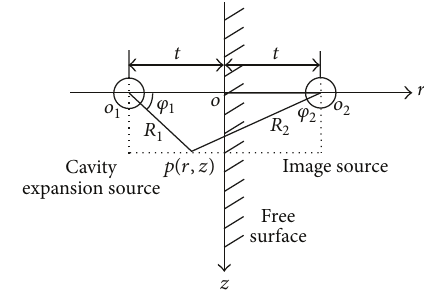
Figure 3: A cavity expansion source and its image.